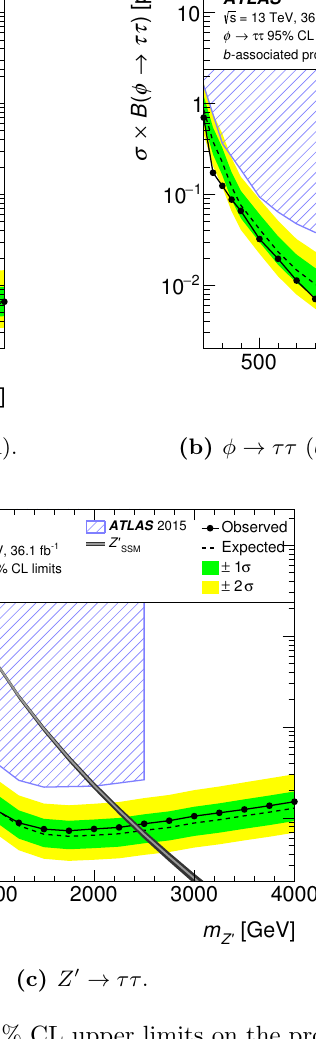
boson is overlaid in SSM